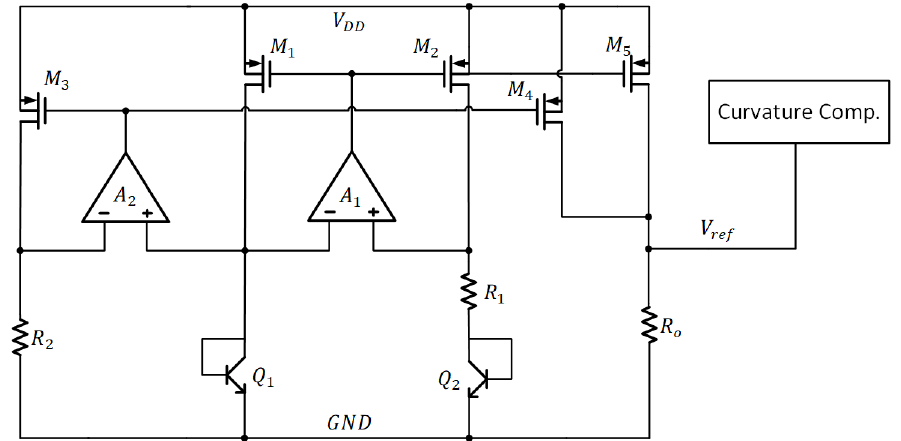
Figure 2. The Current-mode BG Circuit with Low T.C.